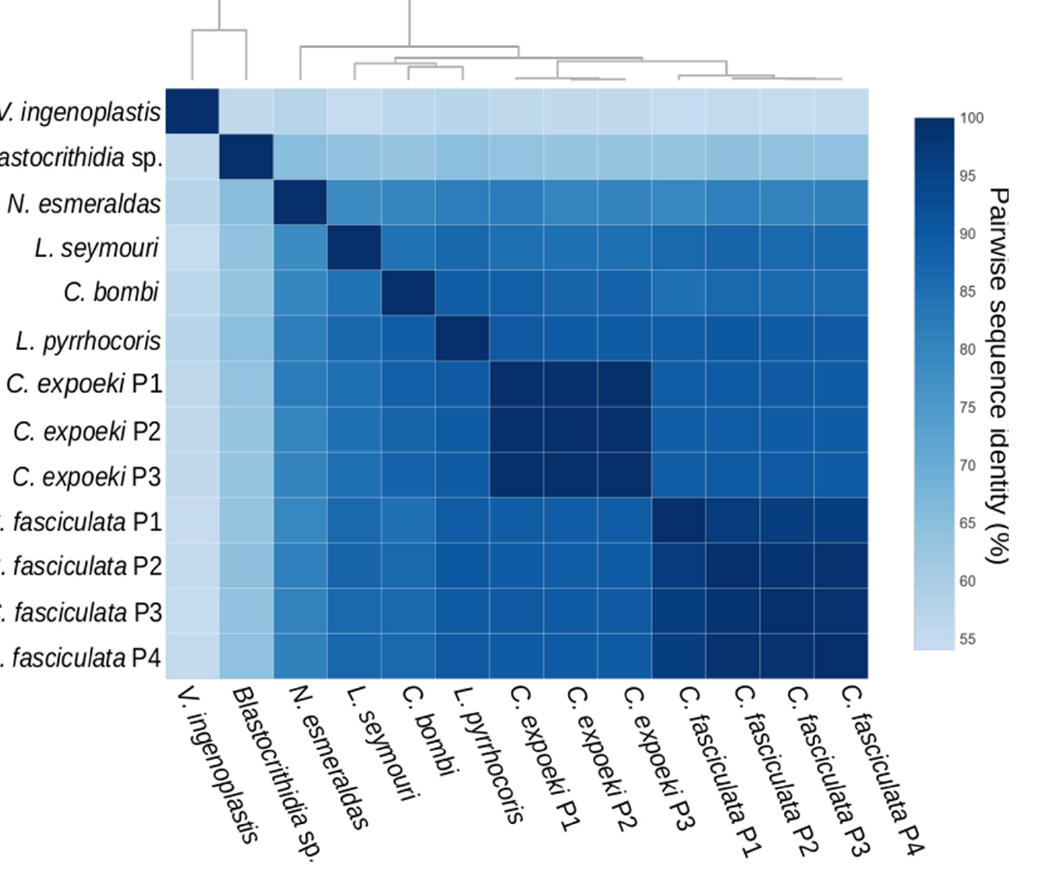
Figure 3. Heatmap for the pairwise sequence identity percentage at the amino acid level between 13 catalase sequences. The color brightness reflects the identity percentage. A dendrogram on top visualizes the result of hierarchical clustering calculations. Full species names and sequence IDs are listed in Table S1. The source data for this diagram are in Table S3.